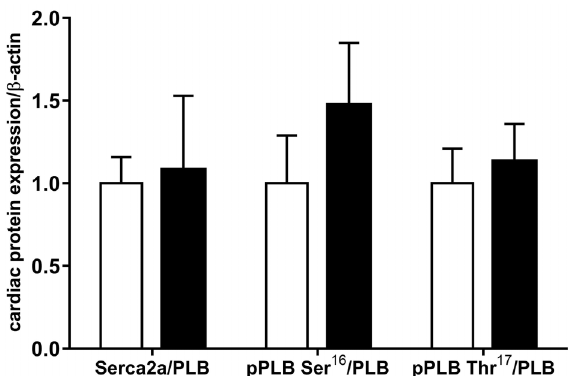
Figure 6. Quanti fi cation of sarcoplasmic reticulum Ca 2 + -ATPase (SERCA2a), phospholamban (PLB), serine-16 phosphorylation (pPLB Ser 16 ), and PLB threonine-17 phosphorylation (pPLB Thr 17 ) normalized to PLB. Control: white bars; Obese: black bars (n=6 in each group). Data are reported as means ± SD. Student ’ s t -test for independent samples was used to compare